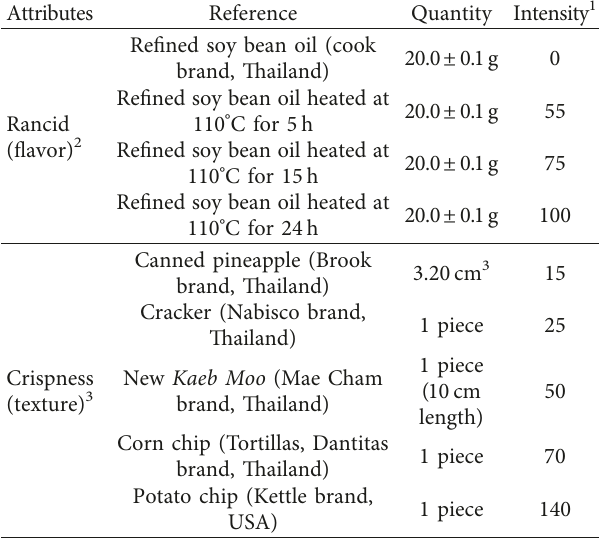
Table 1: Standard references for intensity rating used for training sensory